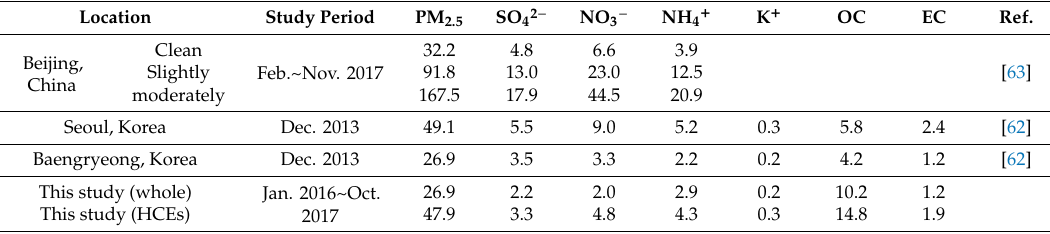
Table 6. Comparisons of measured concentrations of PM 2.5 and its chemical constituents with those reported in other studies. Unit of concentration is µ g m − 3 .